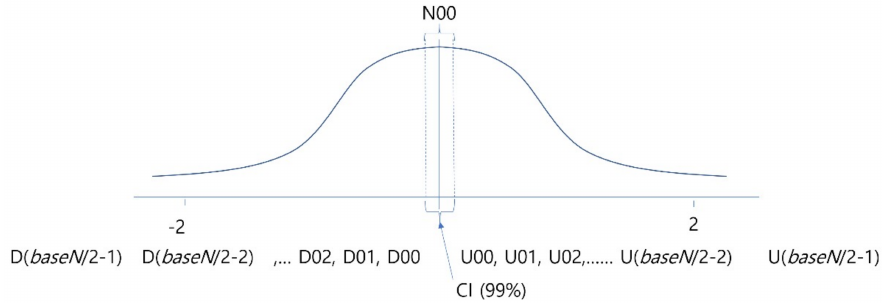
Figure 4. Analyzing overall data distribution for deciding quantization interval and